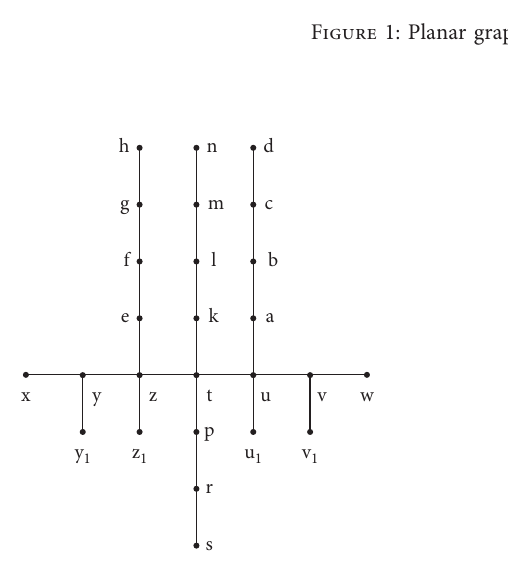
: xyztuvw , by 1 , by adding the path 1